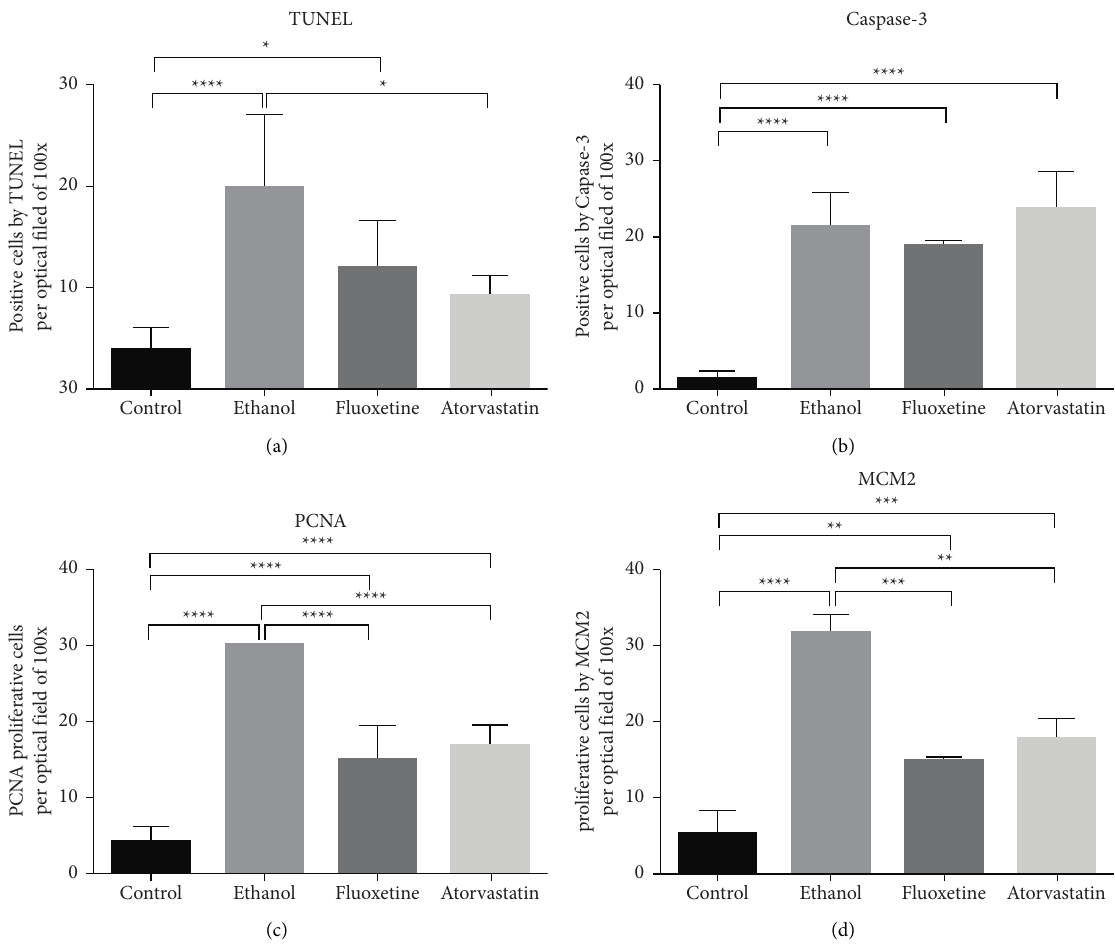
Figure 8: Positive-cells by TUNEL (a) and activated caspase-3 (b) and proliferative cells by PCNA (c) and MCM2 (d) per optical field of 100X. Results are shown as mean ± SD; ∗ denotes P ≤ 0 . 05; ∗∗ denotes P ≤ 0 . 01; ∗∗∗ denotes P ≤ 0 . 001; and ∗∗∗∗ denotes P ≤ 0 .